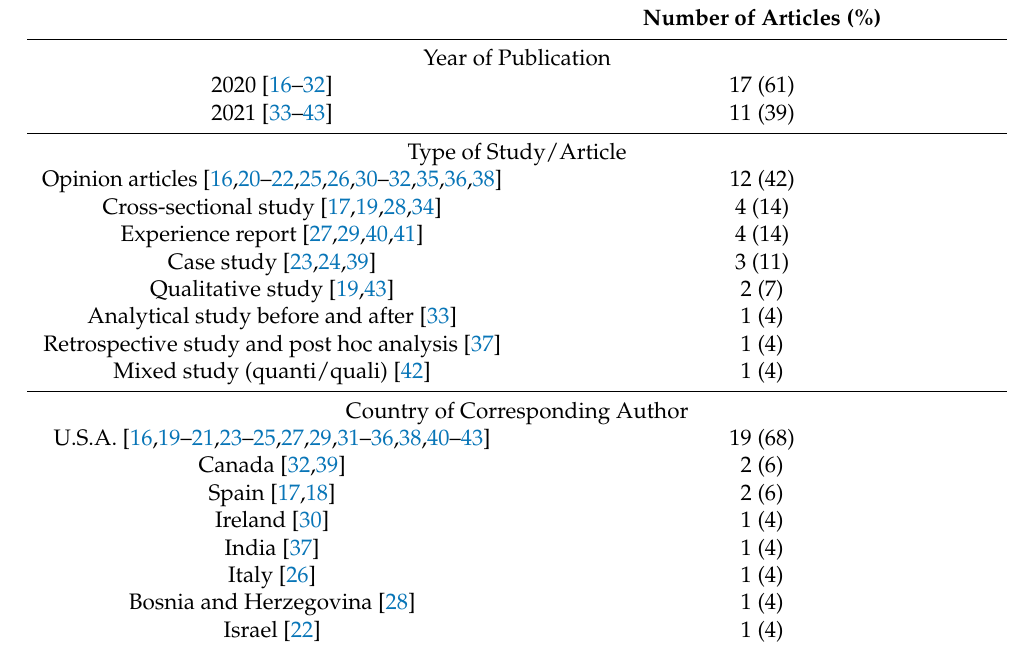
Table 1. Descriptive analysis of articles that propose strategies ( n = 28).